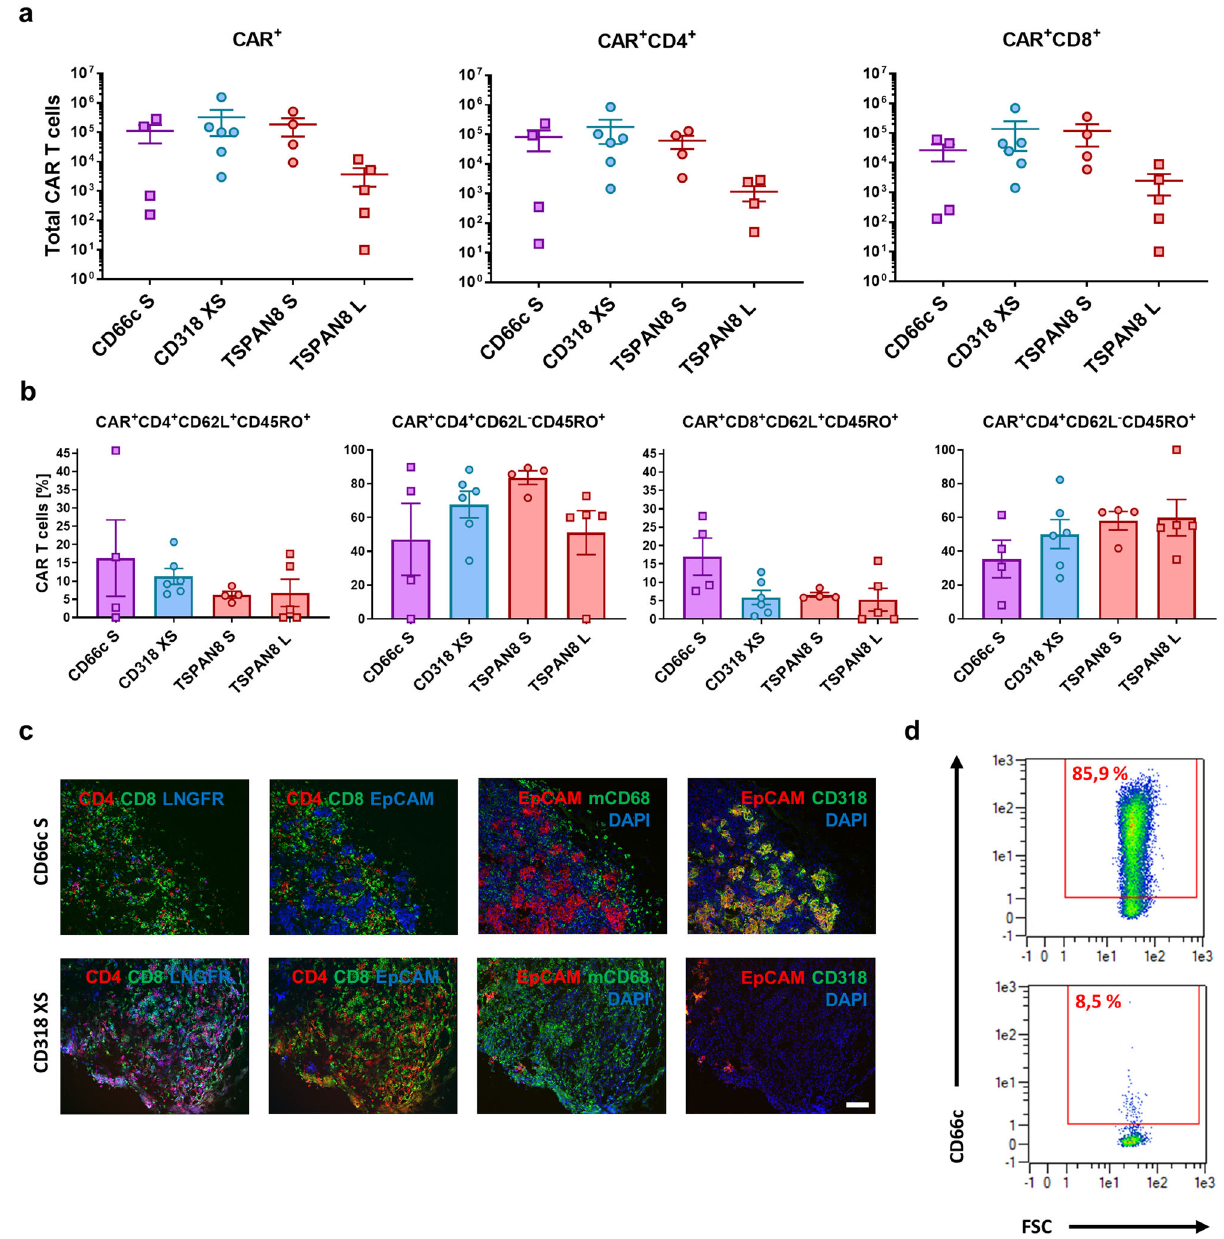
Fig. 5 Ex vivo analysis of the T cell phenotype and AsPC1-derived tumor tissues upon treatment with CAR T cells. a Number of CAR T cells in the spleen at the end of the experiment 27 days post CAR T cell injection (CD66c S: n = 4, CD318 XS: n = 6, TSPAN8 S: n = 4, TSPAN8 L: n = 5). b Phenotype of CAR T cells in the spleen at the end of the experiment 27 days post CAR T cell injection, as demonstrated by the percentage of T CM and T EM ( n equal to a ). All data are shown as mean ± s.e.m. c Representative immuno fl uorescence images of (CAR) T cell tumor in fi ltration, macrophage tumor in fi ltration and target expression (CD318 XS tumor 9 days post CAR T cell injection, CD66c S tumor 27 days post CAR T cell injection). Staining was performed on one tumor of the respective treatment group and each image is representative for at least two regions of interest. Regions of interest during cyclic IF were chosen based on manual prestaining of DAPI and EpCAM. d Density plots of a dissociated AsPC1 xenograft showing CD66c expression 35 days post injection of 5e 6 CD66c S V l -V h CAR T cells (top) and the unstained control (bottom). Scale bar = 100 µ m. Source data are provided as a Source Data fi